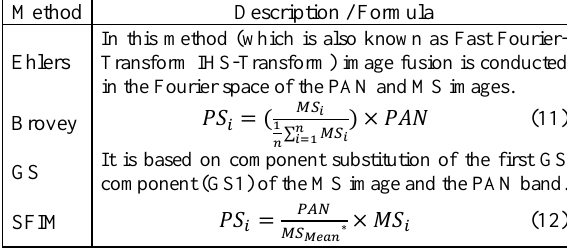
Table 2. Information on PS methods